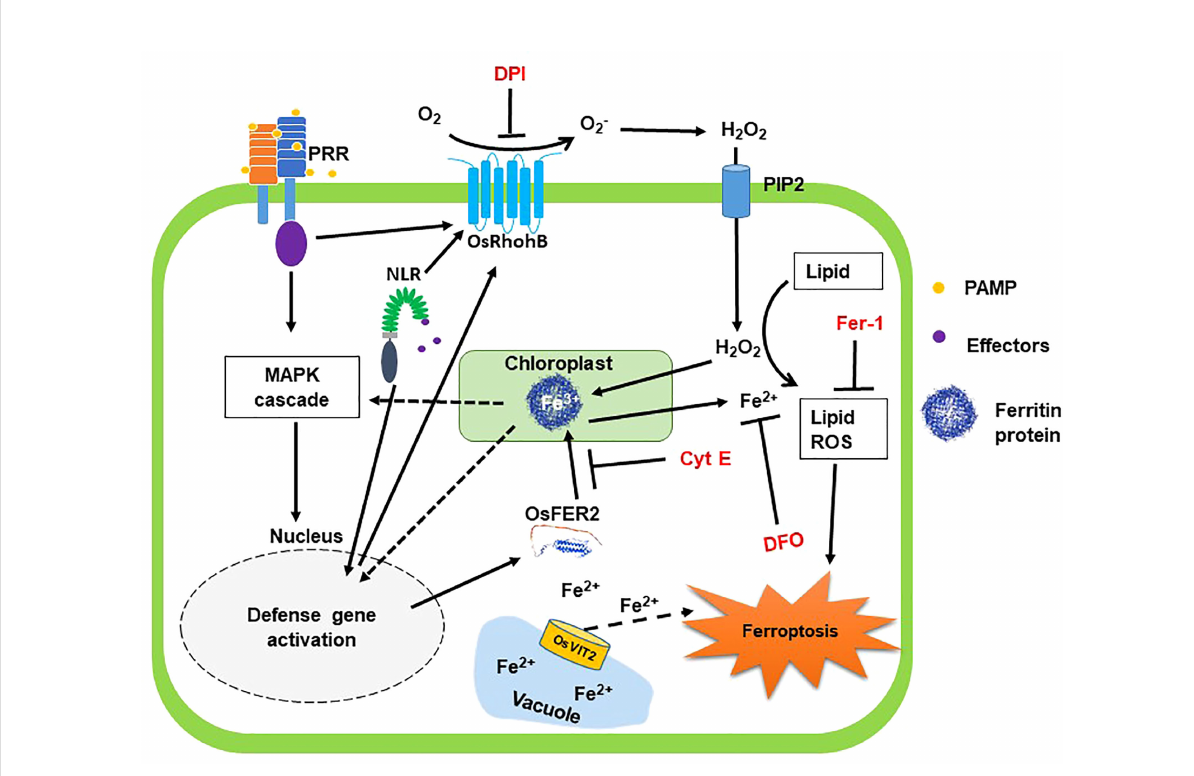
FIGURE 15 Proposed model of rice iron-storage protein ferritin 2 (OsFER2) signaling for iron- and ROS-dependent ferroptotic cell death in rice – Magnaporthe oryzae interactions. During avirulent M. oryzae infection, perception of PAMPs or pathogen effectors via membrane-bound PRRs or NLRs, respectively, triggers OsMAP kinase signaling to the nucleus to induce defense genes in rice cells. Iron is stored in vacuoles and ferritins. OsFER2 is localized to the chloroplast. OsFER2 positively regulates the vacuolar membrane transporter 2, OsVIT2, to maintain iron homeostasis in cells. Iron stored in ferritin contributes to lipid-ROS formation leading to ferroptotic cell death. DFO acts as an iron chelator, adsorbing iron inside the cell. Cyt E inhibits actin micro fi lament polymerization in plant cells. Fer-1 blocks lipid peroxidation and DPI inhibits NADPH oxidase activity. The small-molecule ferroptosis inhibitors DFO, Cyt E, Fer-1 and DPI are in red. Solid arrows and solid T-shaped lines indicate positive and negative regulations, respectively. Dotted arrows indicate indirect or unveri fi ed connections. NLR, nucleotide-binding leucine-rich repeat; PAMP, pathogen-associated molecular pattern; PRR, pattern recognition receptor; PIP2, aquaporin